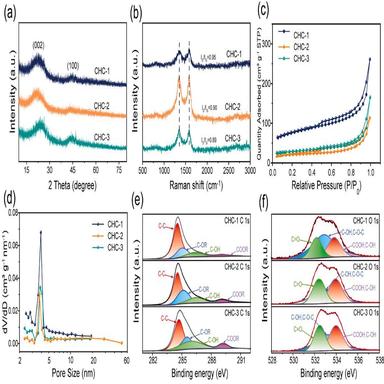
(a) XRD patterns, (b) Raman spectra, (c) Nitrogen adsorption-desorption isotherm curves, (d) Pore size distributions, (e) high-resolution C 1s, and (f) highresolution O 1s spectra for CHC samples.